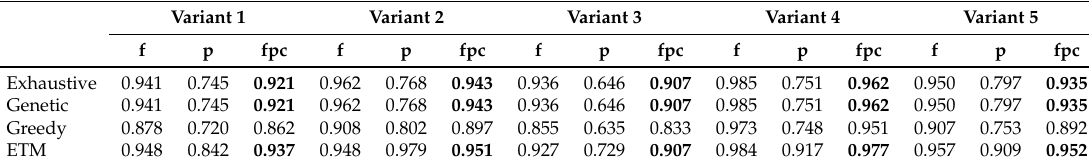
Table 2. Results for CPT 3-A and the event logs corresponding to the five process variants.